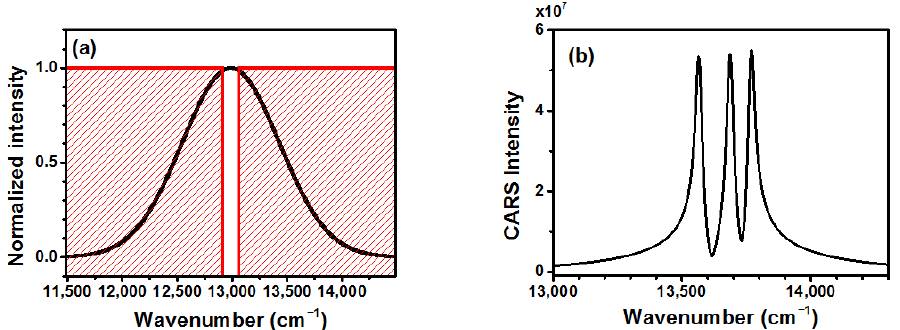
Figure 2. ( a ) Schematic of the modulation of the probe laser spectrum, and ( b ) CARS spectra for shaped probe pulse with the spectral width of 16 cm − 1 , centered at the wavenumber of 12,987 cm − 1 . By modulating the amplitude and the phase of the pump and the Stokes light, selective excitation of the stimulated Raman spectrum can be realized [37,38,41]. The modulating schemes for the pump and Stokes laser are shown in Figure 3a,b, respectively. The minimal interval in the frequency domain is 2 cm − 1 . Figure 3a shows the modulation of the pump laser spectrum. The frequency components in the window with a fixed width centered at 12,987 cm − 1 are preserved, and the frequency components outside this window are cut off. A rectangular π -phase modulation with one-third the width of the window is applied to the central part, as shown by the blue solid line in Figure 3a [37,38]. For the Stokes laser, the frequency components outside the window with a width equal to that of the pump laser are cut off. A rectangular π -phase modulation with one-third the width of the window is applied in the middle of the window, while the others remain in the 0-phase, as shown in Figure 3b. The center of the modulation window of the pump light is fixed at 12,987 cm − 1 , while that of the Stokes light scans from low to high frequency. In addition to the rectangular π -phase modulation, it also scans from low to high frequency, as shown by the green arrow in Figure 3b. Figure 3b shows the modulation when the window moves to a certain position. The window sizes of the pump and the Stokes light can be adjusted to obtain the best Raman selective excitation. The selected Raman peak has a higher intensity and a larger contrast with the suppressed Raman